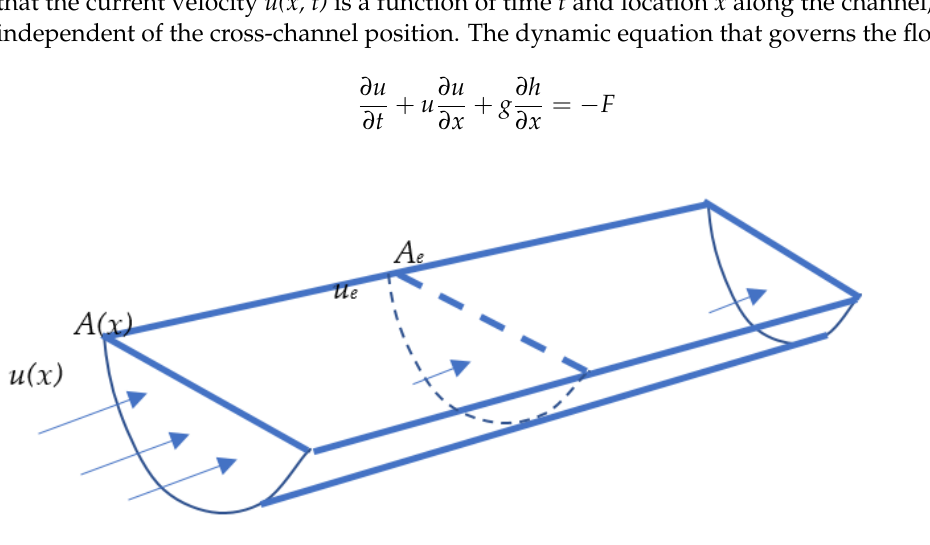
Figure 12. Flow through a channel [7].